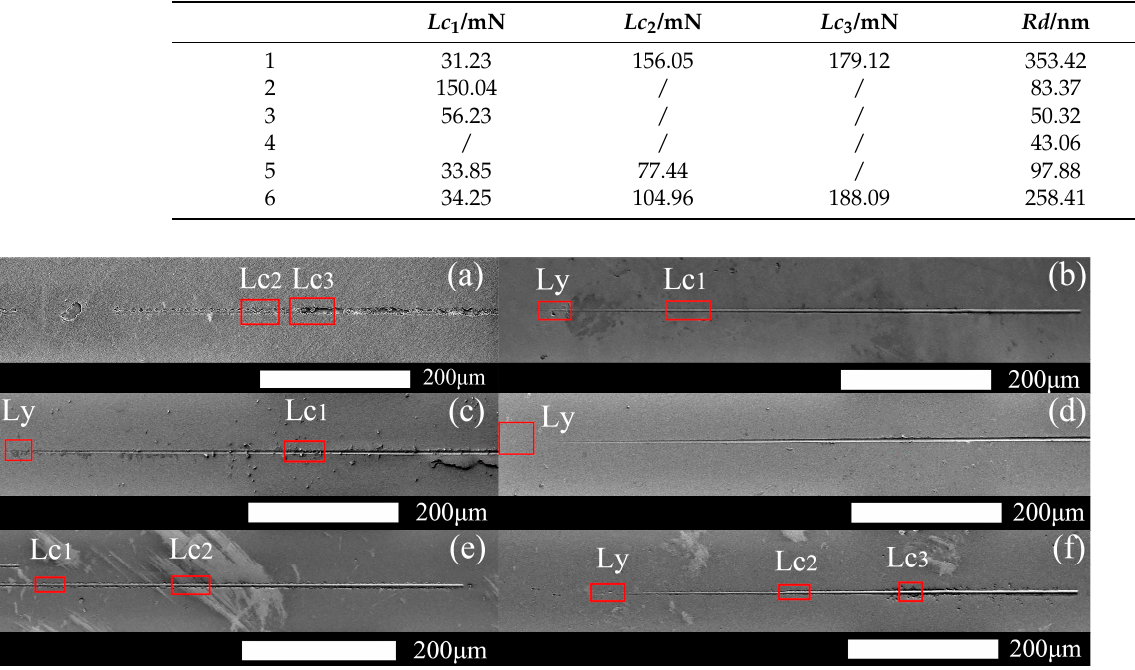
Figure 6. Residual scratch morphology of the Si-B-C-N/DLC gradient films. ( a ) Sample 1, ( b ) Sample 2, ( c ) Sample 3, ( d ) Sample 4, ( e ) Sample 5, ( f ) Sample 6.